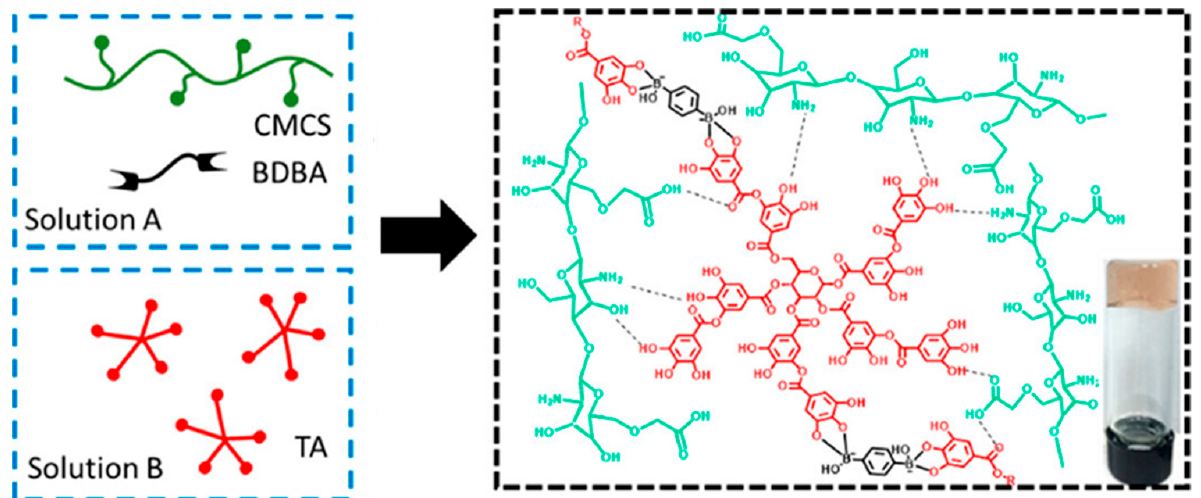
Figure 3. Formation of CMCS–TA–BDBA hydrogel via hydrogen bonding and boronate ester bonds with TA (adapted with permission from Geng et al., 2020).